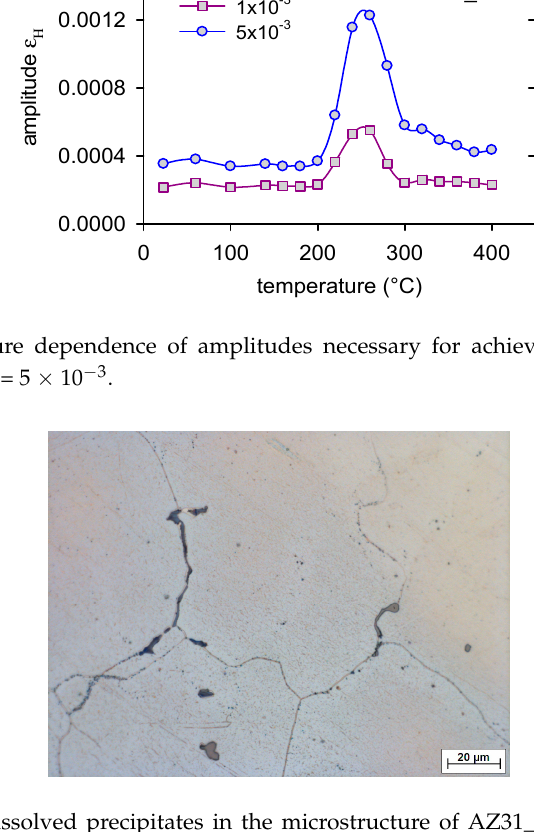
Figure 5. Partially-dissolved precipitates in the microstructure of AZ31_CC after annealing and quenching step by step up to 400 °C.